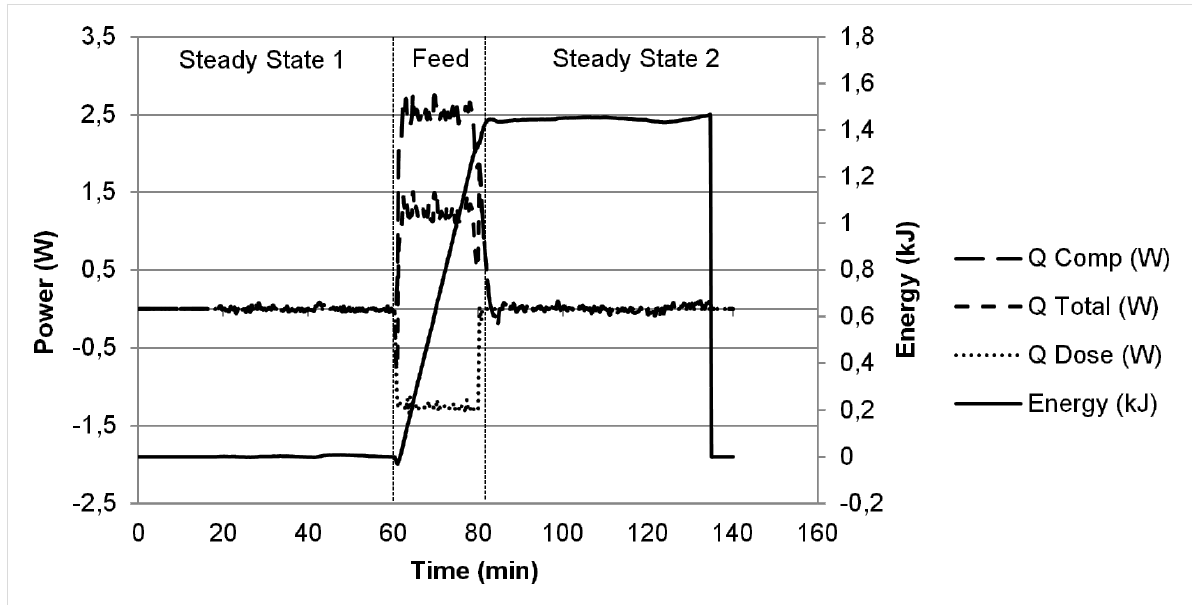
Figure 1: Calorimeter trace for the single phase reaction of morpholine (aq) and NaOCl (aq). Q Comp: compensatory power, Q Total: total power, Q Dose: power delivered by dosing of room temperature NaOCl (aq) to cooled reaction solution. Energy: heat